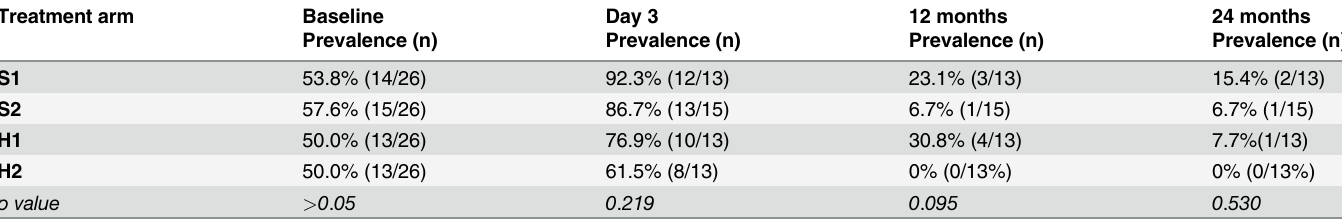
Table 6. Change in adult worm prevalence on ultrasonography seen as Filarial Dance Sign (FDS). Treatment arm